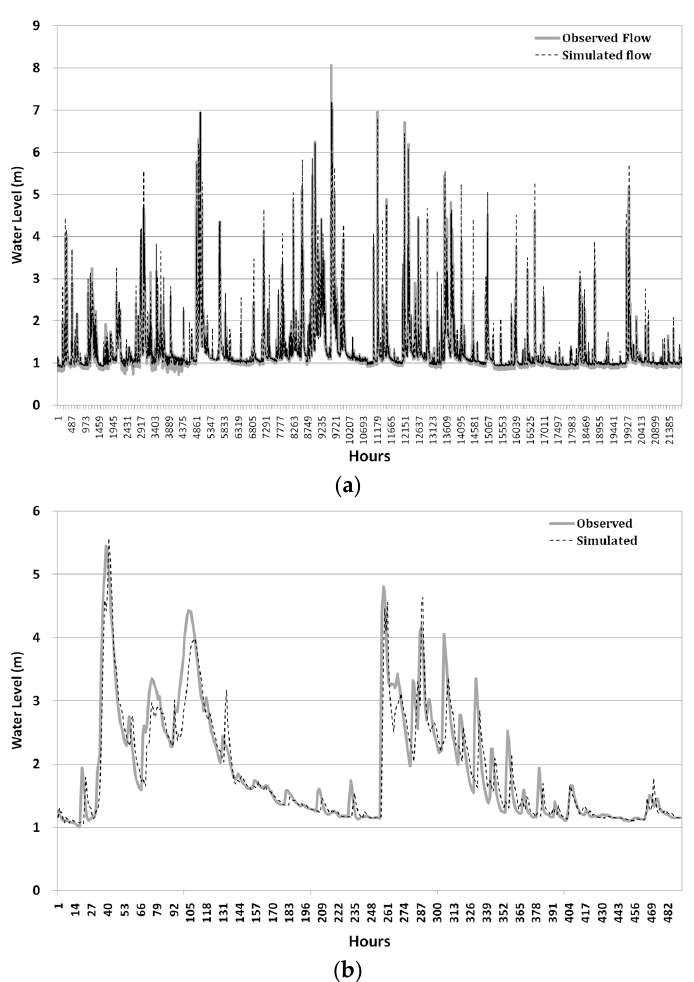
Figure 14. Comparison of observed and forecasted water levels with a lead-time of 3 h. ( a ) Water level of training and testing periods; ( b ) Water level of some period in testing data set.